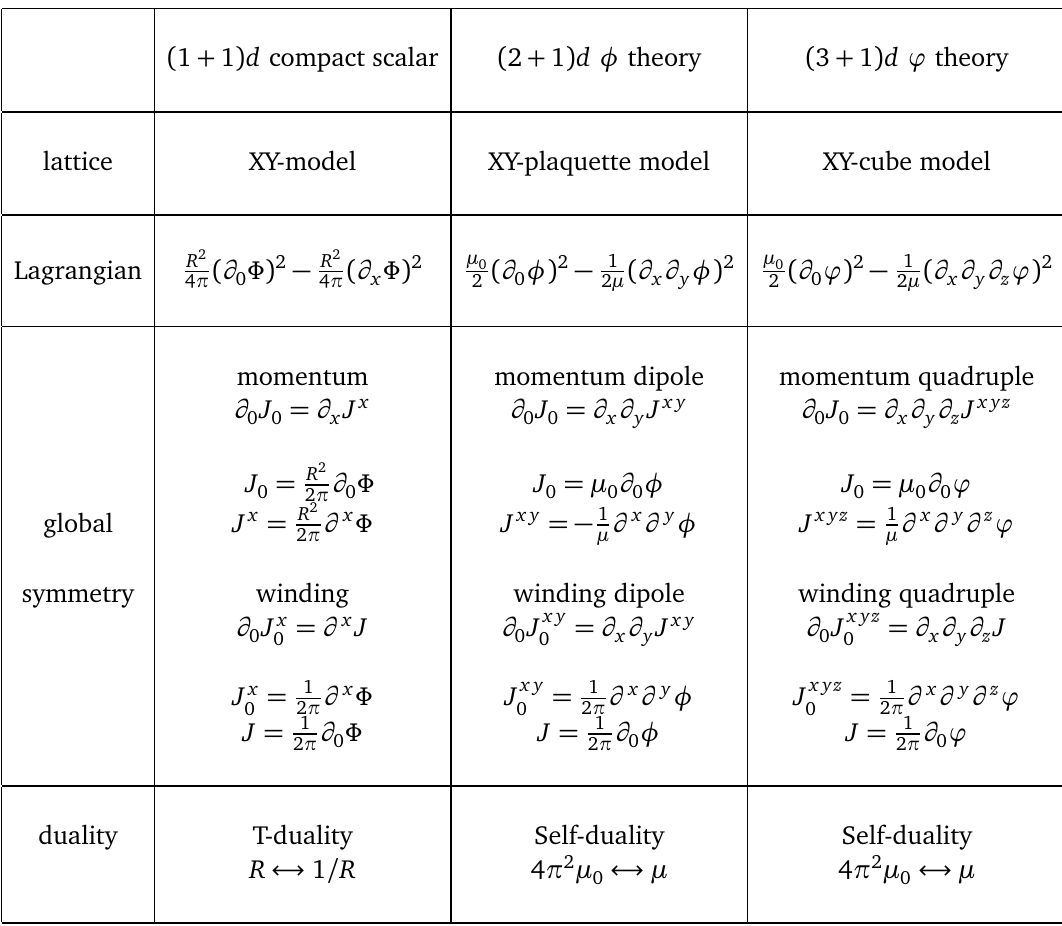
Table 1: Analogy between the ordinary 1 + 1-dimensional compact scalar theory, the 2 + 1-dimensional φ -theory of [ 3 ] , and the 3 + 1-dimensional ϕ theory of Section